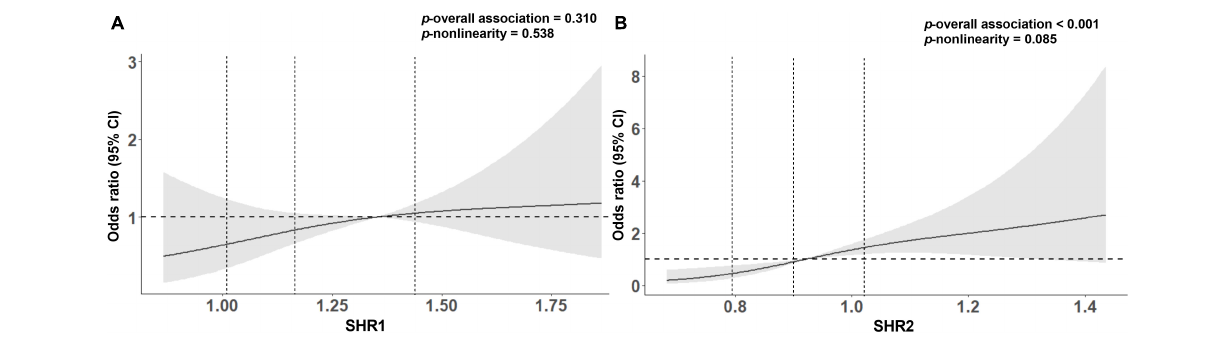
sensitivity analysis compared with the main analysis ( Table 3